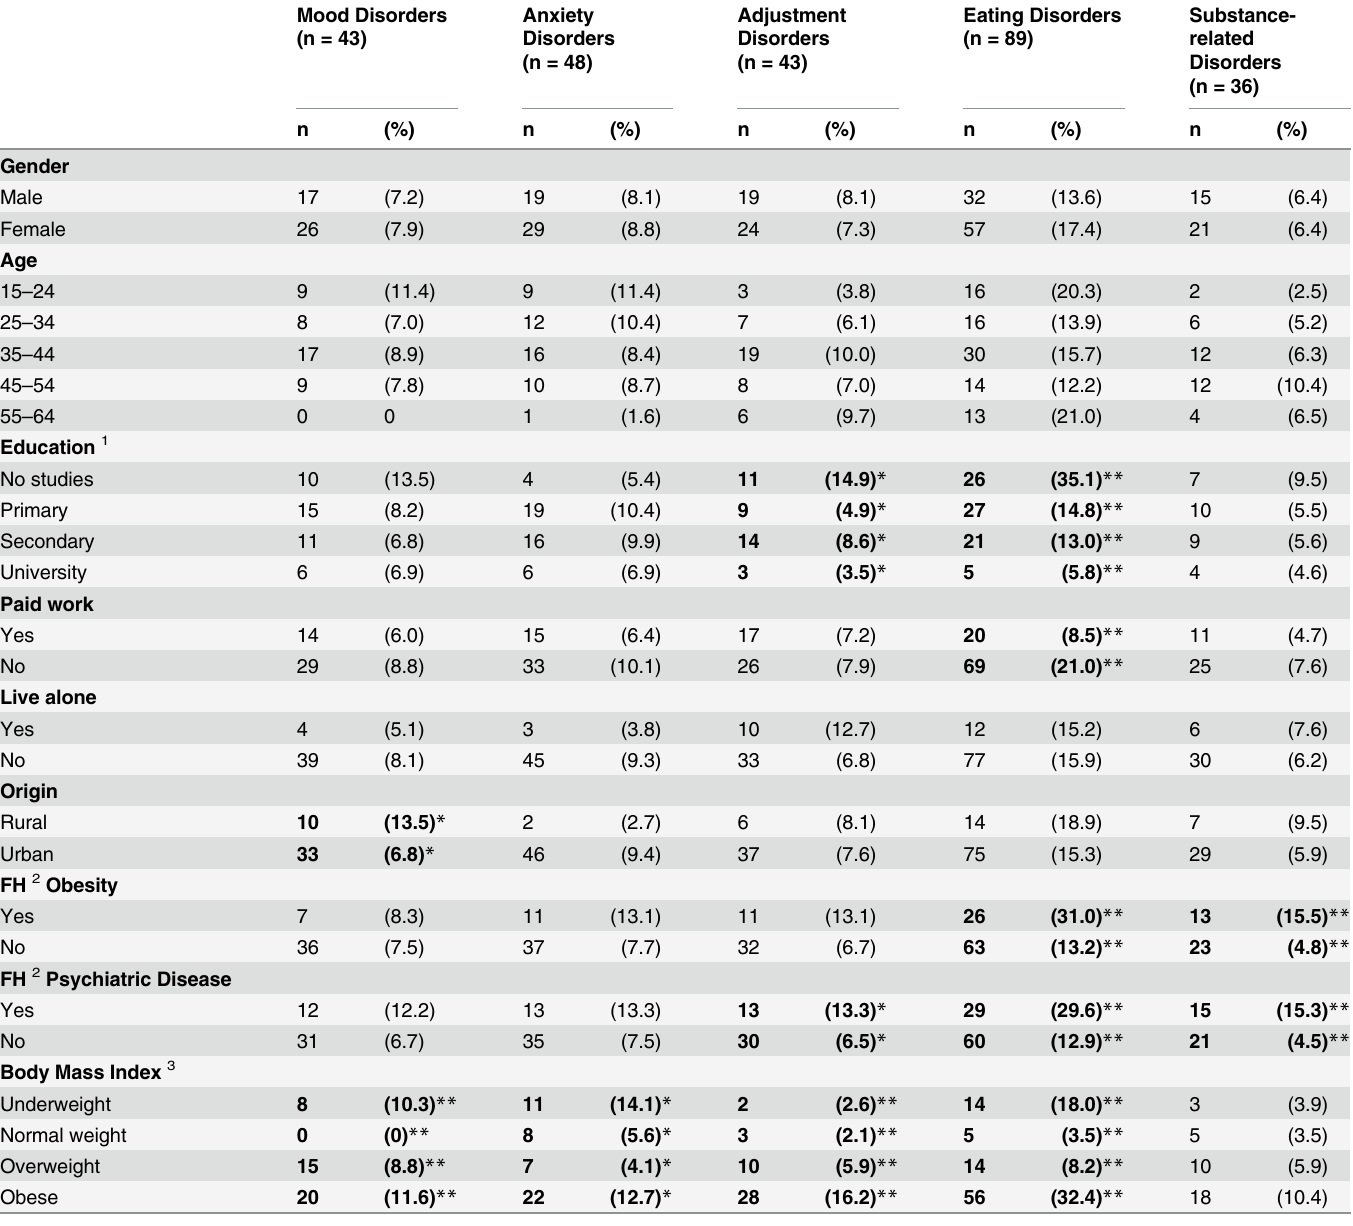
Table 2. Frequency of Axis I psychiatric disorders by socio-demographic variables and